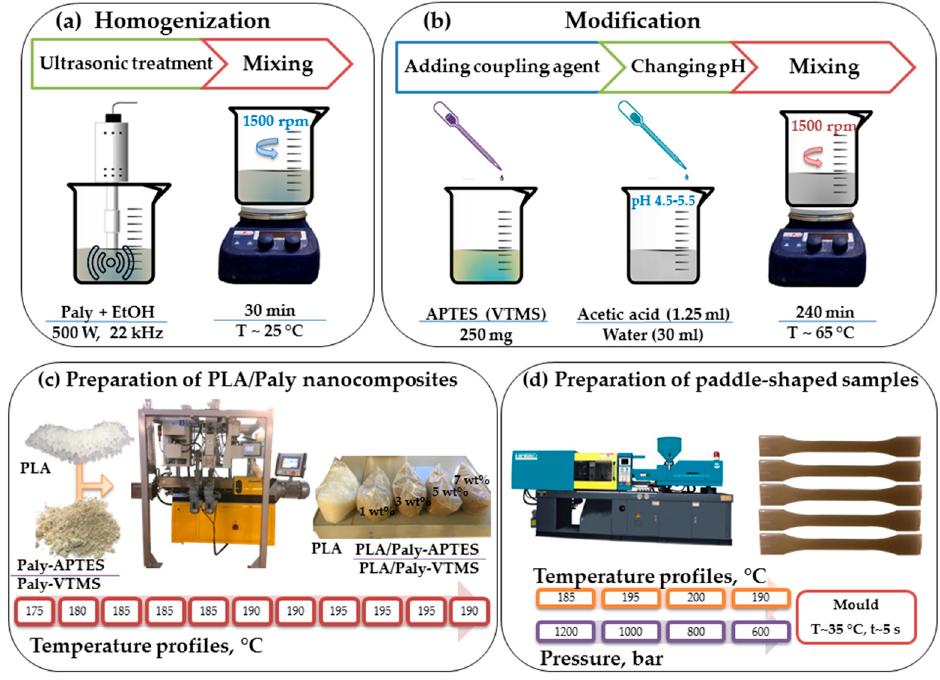
Figure 1. Schematic representation of the processes for modification of Paly ( a , b ) and preparation of poly(lactic acid) (PLA)/palygorskite (Paly) nanocomposites ( c , d ). APTES, 3-aminopropyltriethoxysilane; VTMS, vinyltrimethoxysilane.